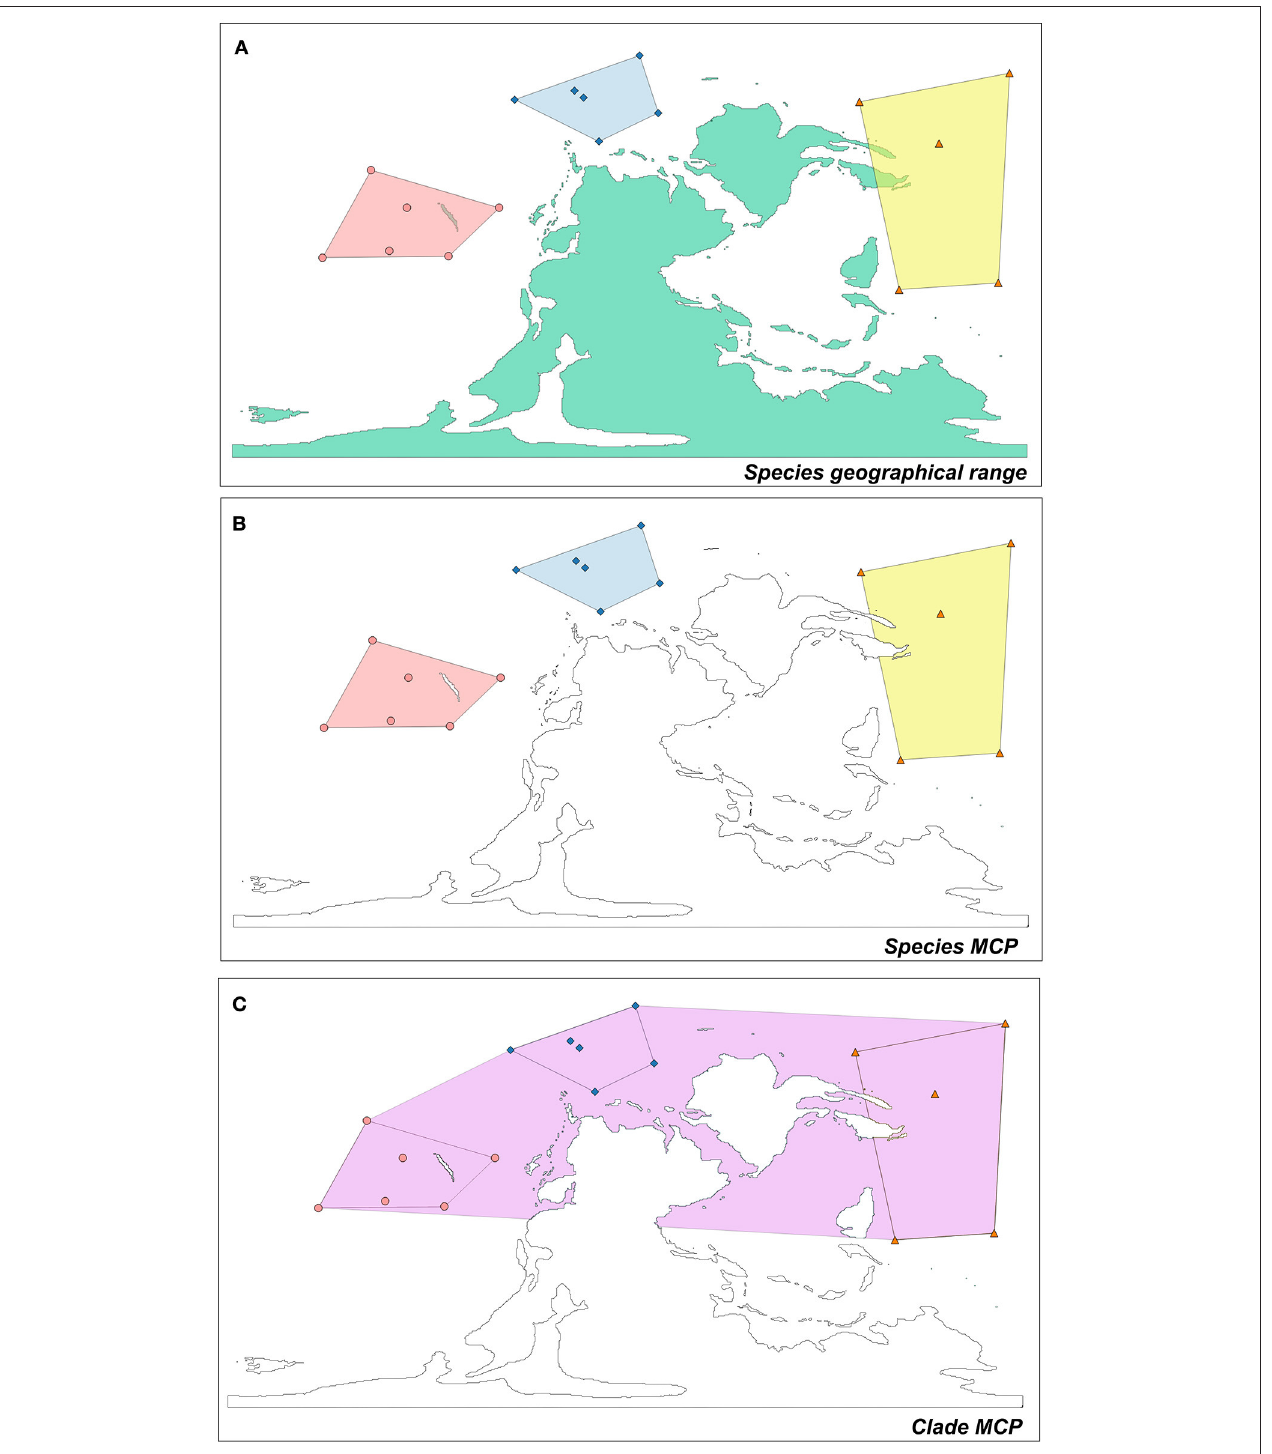
FIGURE 1 | Criteria for clade and species range size estimation. (A) The computation of the MCP of three different species in a temporal bin. The colors (yellow, pink, and light red) indicate the different geographical distribution of the species. In (B) land portions are removed in order to compute species MCPs. (C) The calculation of clade-level MCP, considering all the occurrences of all the species belonging to the clade in a given temporal bin.